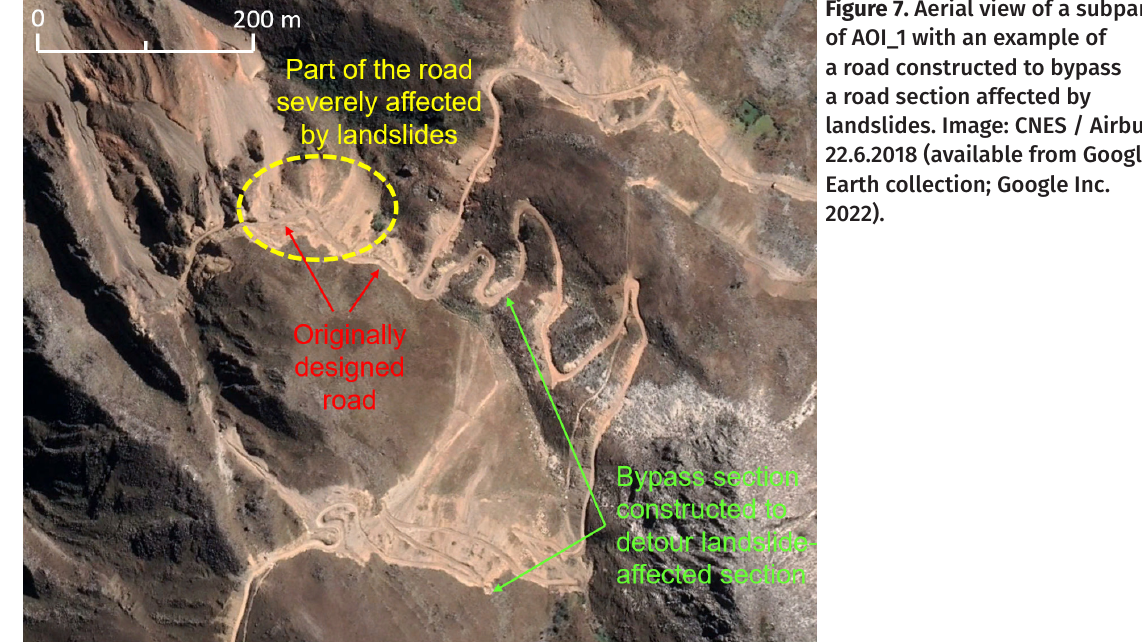
Figure 7. Aerial view of a subpart of AOI_1 with an example